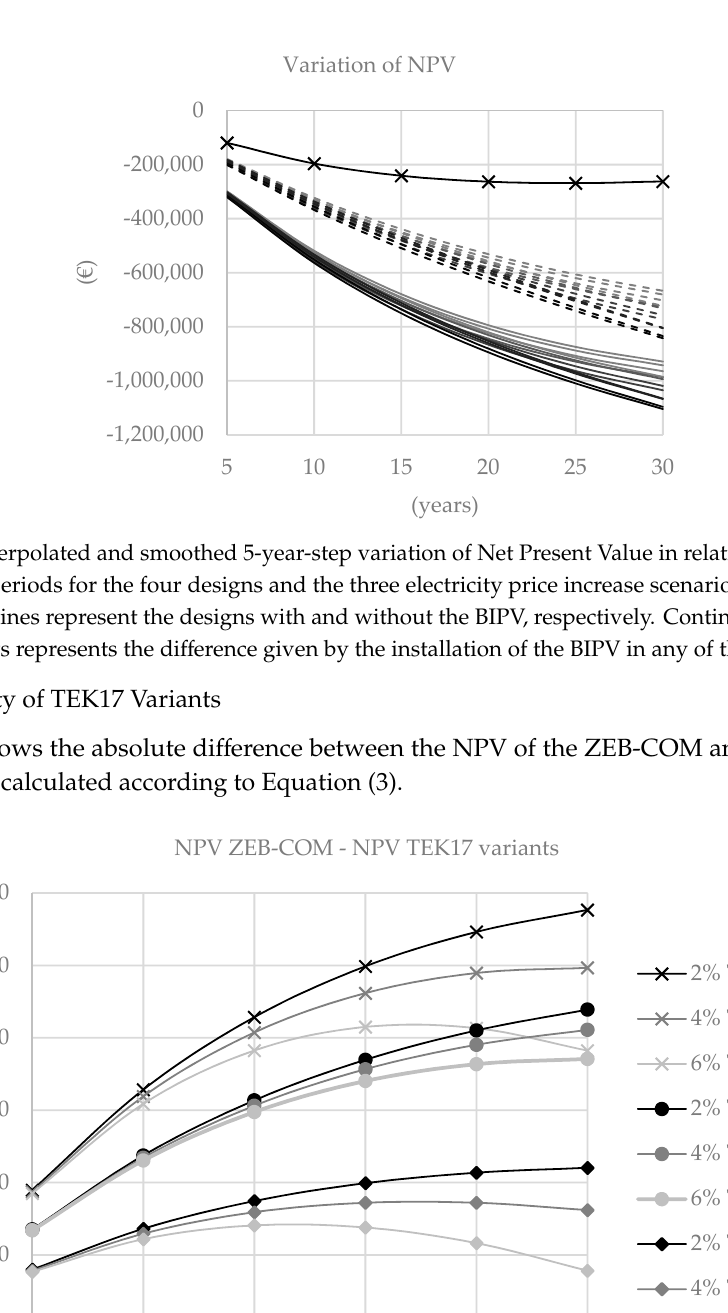
Figure 4. Interpolated and smoothed 5-year-step variation of Net Present Value in relation to different calculation periods for the four designs and the three electricity price increase scenarios. Continuous and dashed lines represent the designs with and without the BIPV, respectively. Continuous line with cross markers represents the difference given by the installation of the BIPV in any of the design.